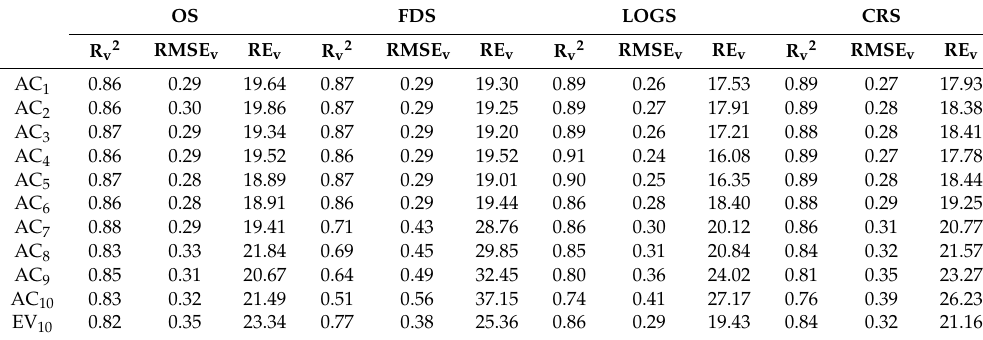
Table 8. Validation of leaf nitrogen concentration estimation models based on a random forest regression with discrete wavelet transform features. AC i denotes approximation coe ffi cient (AC) at L i ; EV 10 is the energy value at L 10